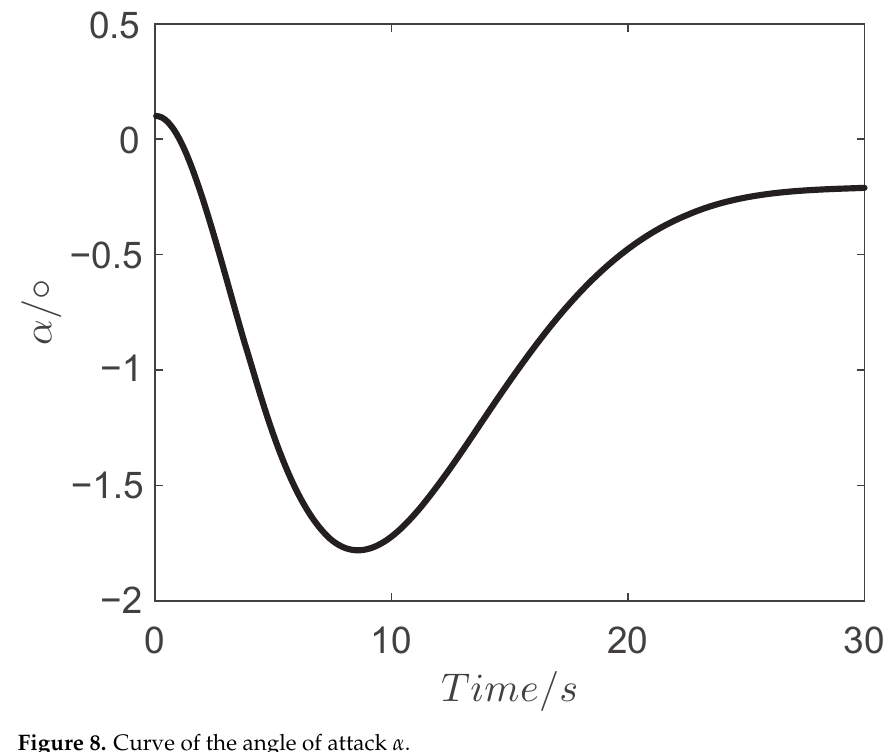
Figure 8. Curve of the angle of attack α .